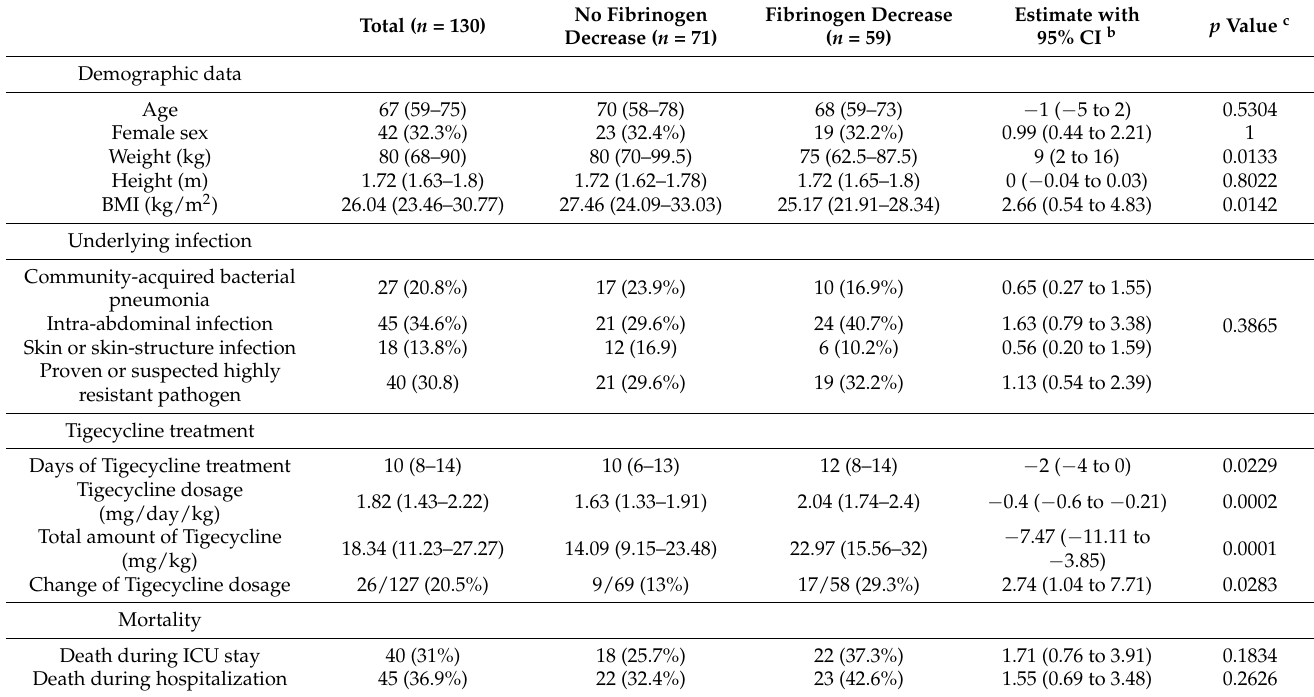
Table 1. Patients’ characteristics, overview of tigecycline treatment and mortality a